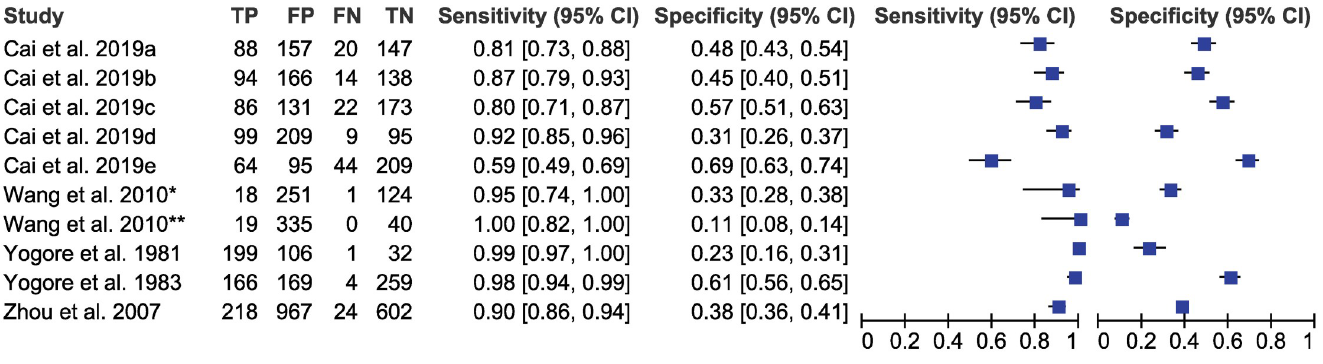
Fig 2. Forest plot of sensitivity/specificity of ELISA ( S . japonicum with stool examination as a reference standard). Note: a-SjSAP5 + Sj23-LHD ELISA; b-SjSAP4 + Sj23-LHD ELISA; c-SjSAP5 ELISA; d-SjSAP4 ELISA; e-Sj23-LHD ELISA; � -AWA ELISA; �� -rsj29